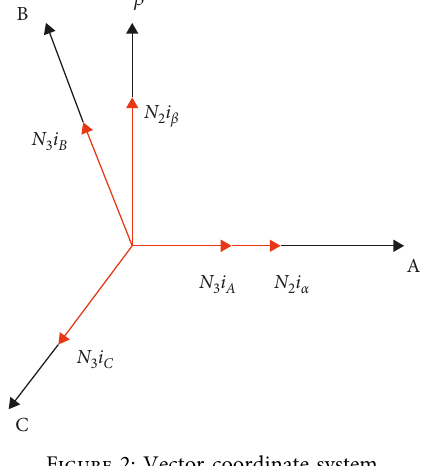
Figure 2: Vector coordinate system.